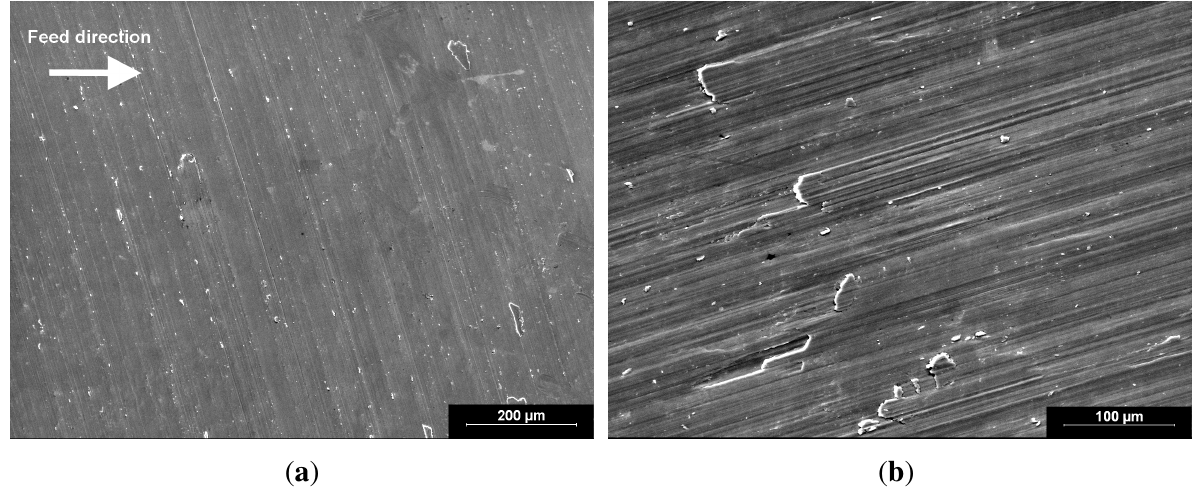
Figure 5. Milled surfaces. ( a ) Run N ◦ 1: V = 54 m/min, ap Run N ◦